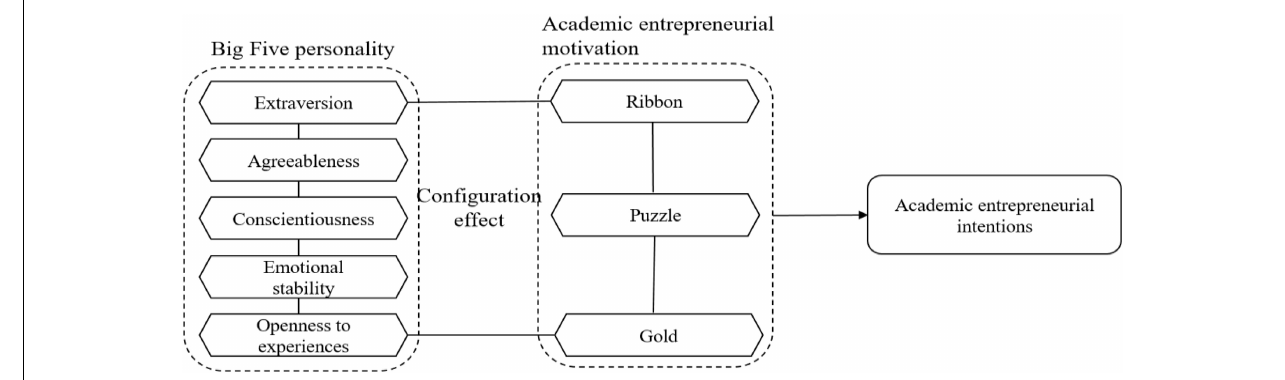
FIGURE 1 | Research